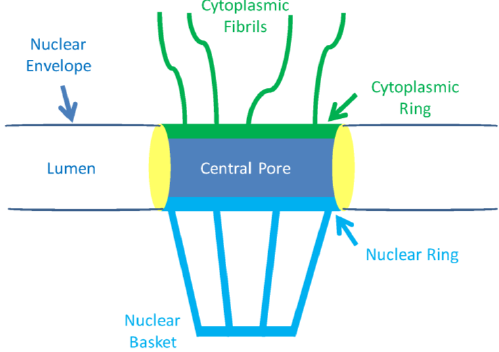
Figure 2. The Nuclear Pore Complex Structure. A schematic cross-section of the nuclear pore complex. The entry and exit of macromolecules from the nucleus is regulated by this